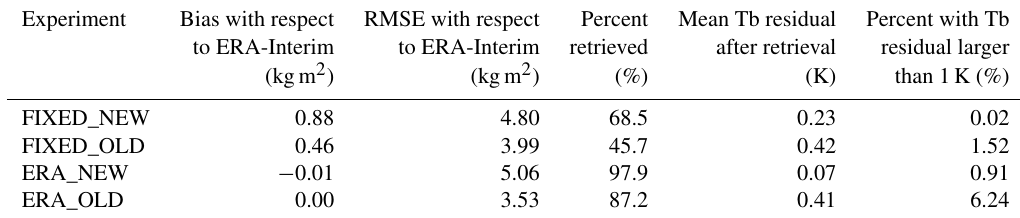
Table 4. Retrieval statistics for the four different 1D-VAR configurations described in Sect. 2.3.1. Corresponding scatterplots are shown in Fig. 8. Total number of retrievals was 35584. Reported bias and RMSE values are for valid only for the fraction of retrievals with cost function lower than